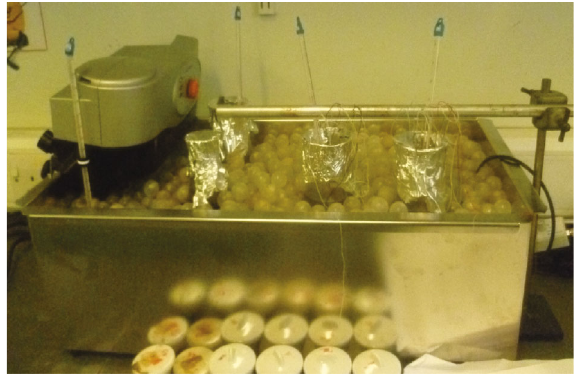
Figure 1: Experimental set-up for isothermal leaching of potato